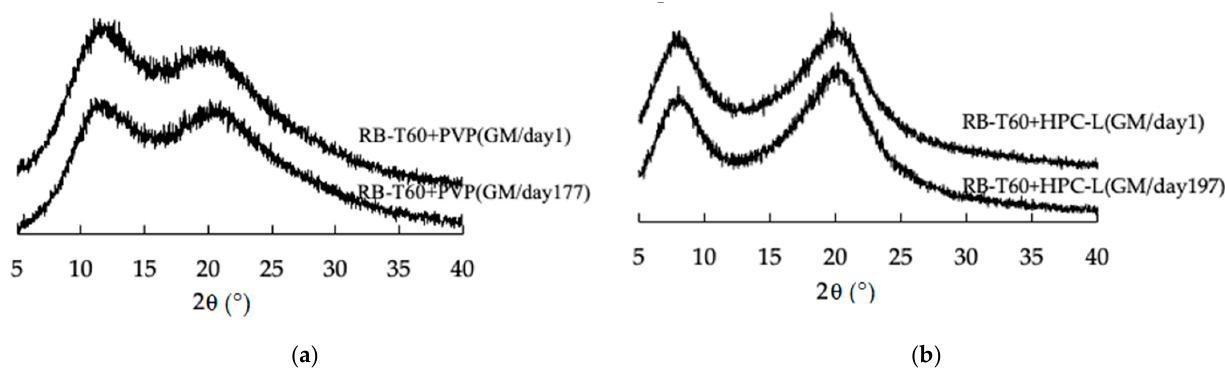
Figure 4. Powder X-ray patterns of samples at storage. ( a ) RB-T60 + PVPK-30 (GM) at day 1 and day 177; ( b ) RB-T60 + HPC-L (GM) at day 1 and day 197.